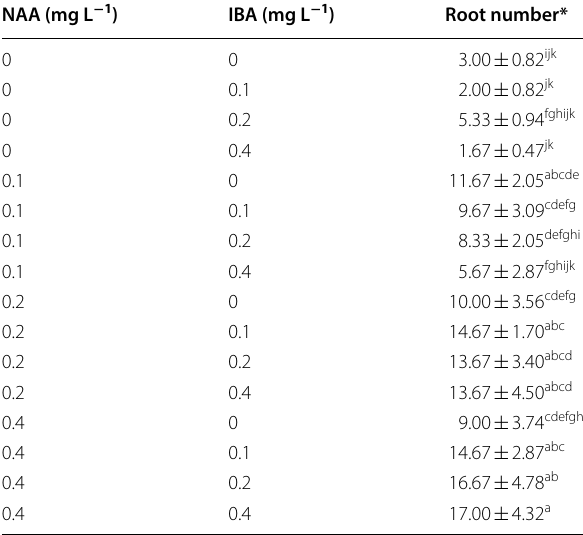
Table 2 Haworthia ‘Sansenjyu’ root formation after cultivation on MS medium with different concentrations of NAA and